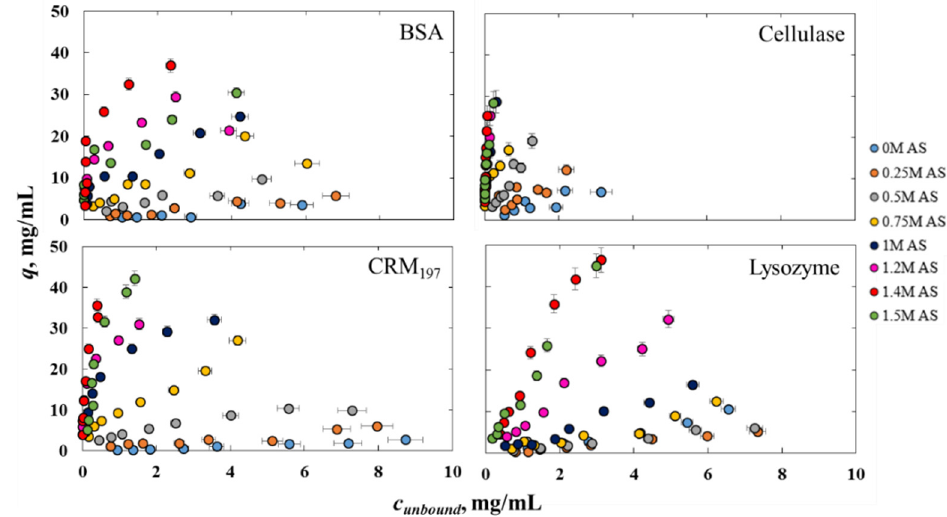
Figure 1. Equilibrium adsorption isotherms of BSA, CRM 197 , Cellulase, and Lysozyme for different concentrations of ammonium sulfate (AS). concentrations of ammonium sulfate